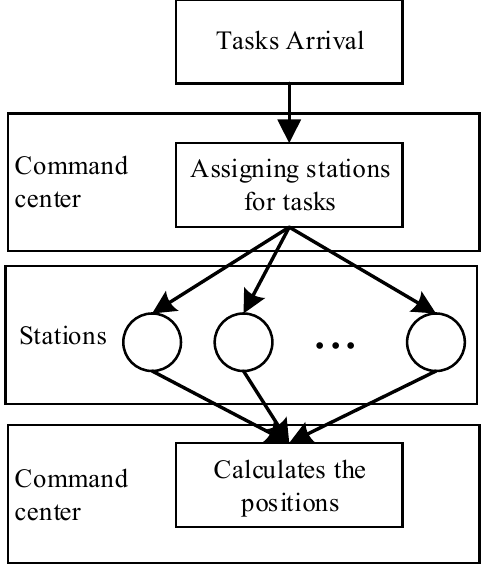
Figure 1. Procedure for passive location in a practical system.